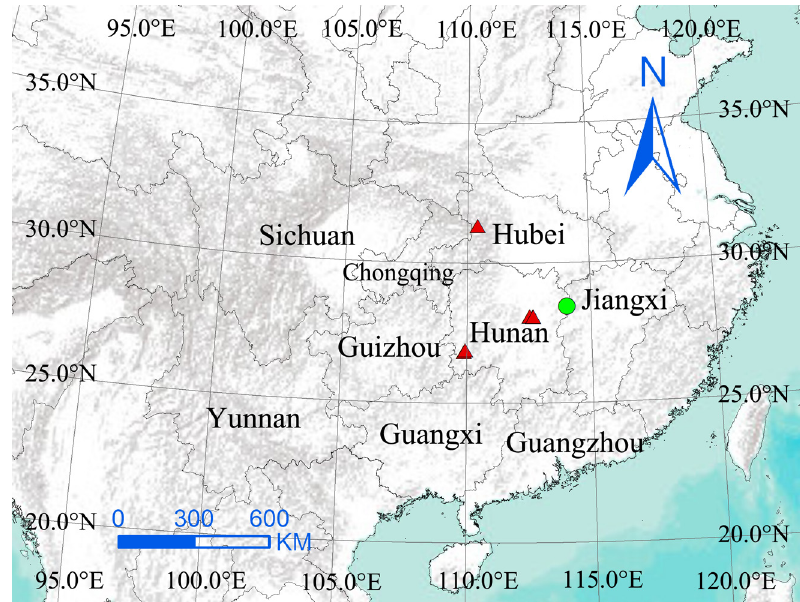
Fig. 11. Distribution of Yuelushannus alatus sp. nov. (green dot) and Y. barbatus sp. nov. (red